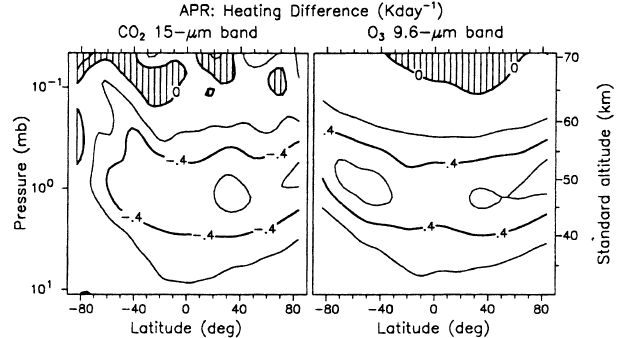
Fig. 5. Same as in Fig. 4 but for quasi-stationary conditions after integration of the model for 1 year